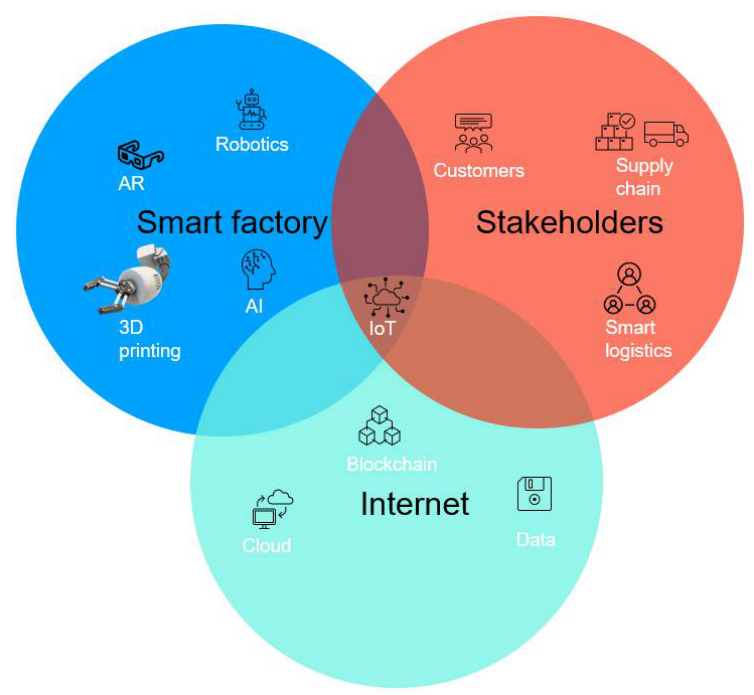
Figure 1. Multiple facets of Industry 4.0 and its integration in the IoT [1].